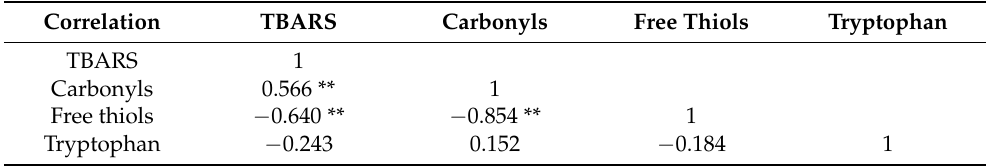
Table 5. Pearson correlation coefficients between TBARS, carbonyls, free thiols, and tryptophan in